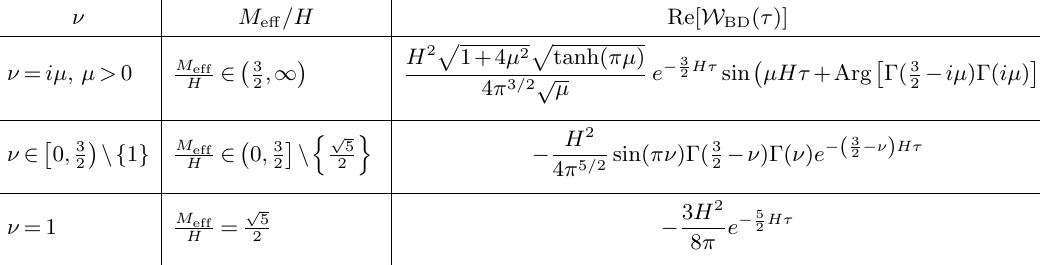
Table 1 . Leading asymptotic behaviour of Re[ W BD ( (cid:28) )] in the limit H(cid:28) (cid:29) 1 for several possible values of M e(cid:11) =H (details given in appendix A). In the (cid:12)rst row (cid:23) = i(cid:22) lies on the positive imaginary p axis with (cid:22) (cid:17) M 2 =H 2 (cid:0) 9 = 4 > 0 ensured because M e(cid:11) =H > 3 . The leading coe(cid:14)cient in the e(cid:11) 2 asymptotic expansion for (cid:23) 2 [0 ; 1) [ (1 ; 3 ) vanishes when (cid:23) ! 1 (cid:6) which is why there is a separate 2 row for the special case of (cid:23) =